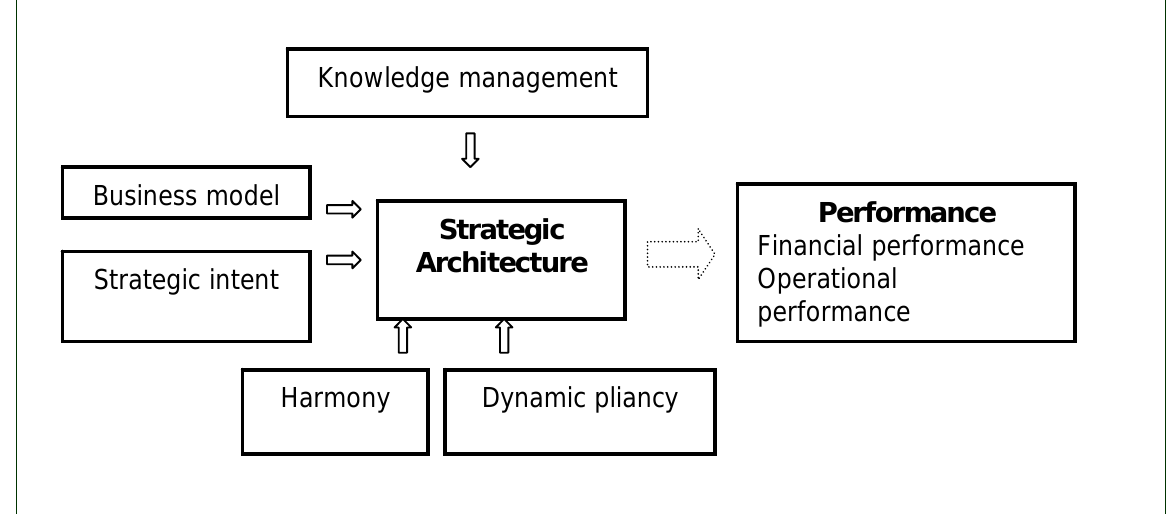
Figure 1: Strategic architecture and its relationship to business